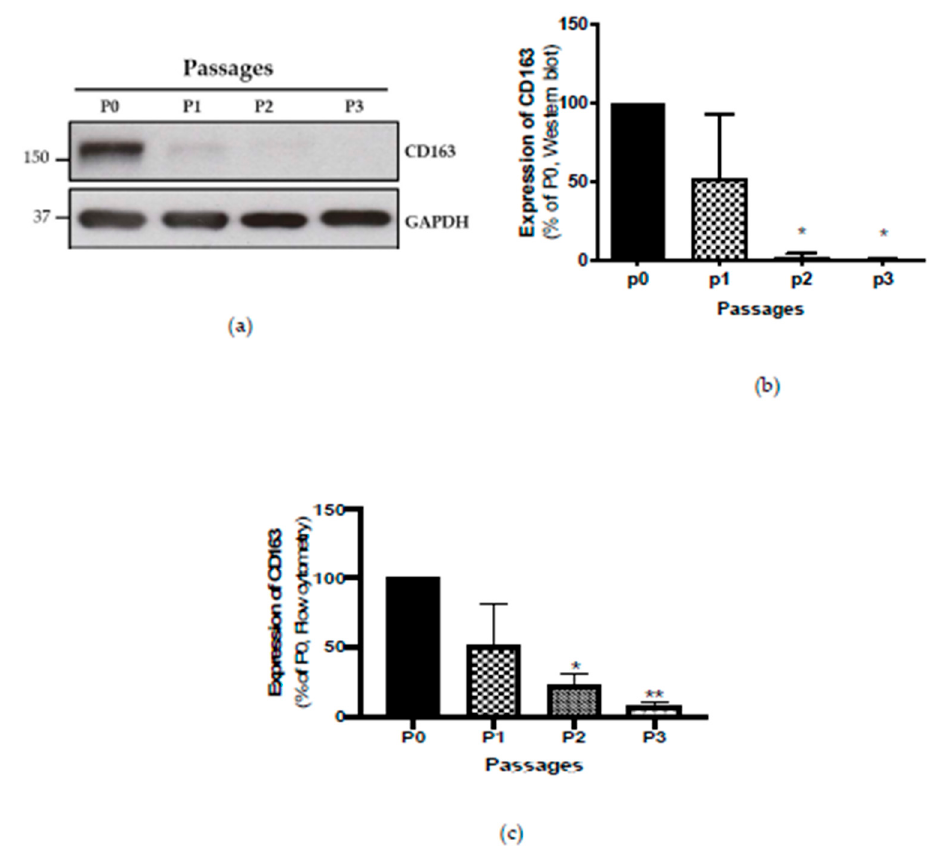
Figure 1. ( a ) Representative Western blot image of expression of CD163 over Passages 0 to 3 ( b ) Bar represents average value of CD163 expression by Western blot normalised to Passage 0 (p0, n = 3) ( c ) Bar represents average value of CD163 expression by flow cytometry normalised to Passage 0 ( n = 3), * p ≤ 0.05, ** p ≤ 0.01.